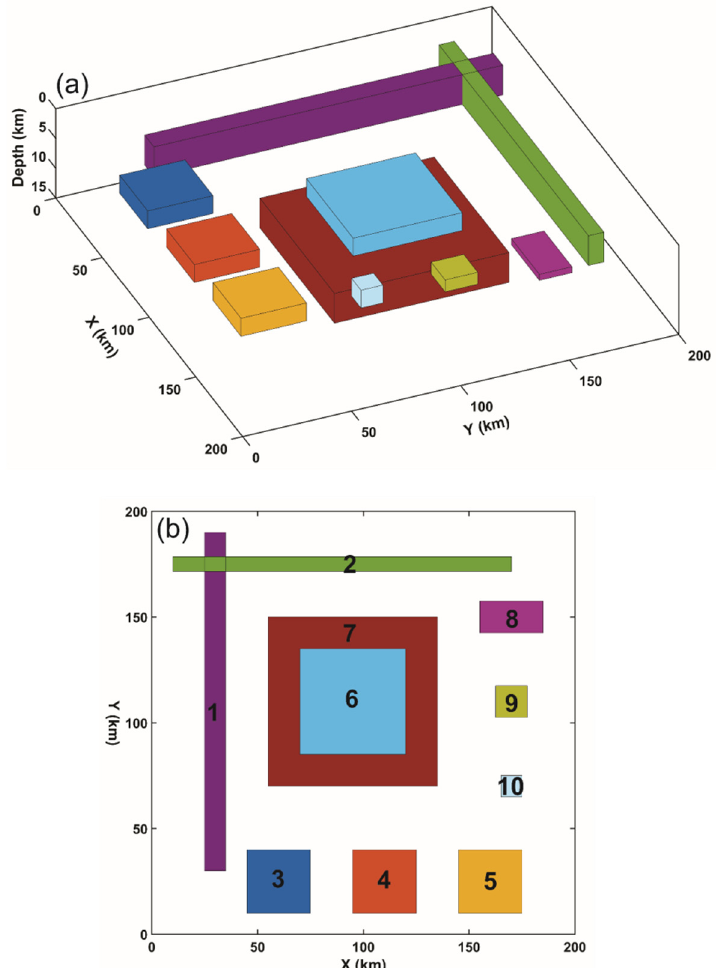
Figure 3. Schematic representation of the synthetic model consisting of ten prismatic bodies in ( a ) 3D view and ( b ) plan view.